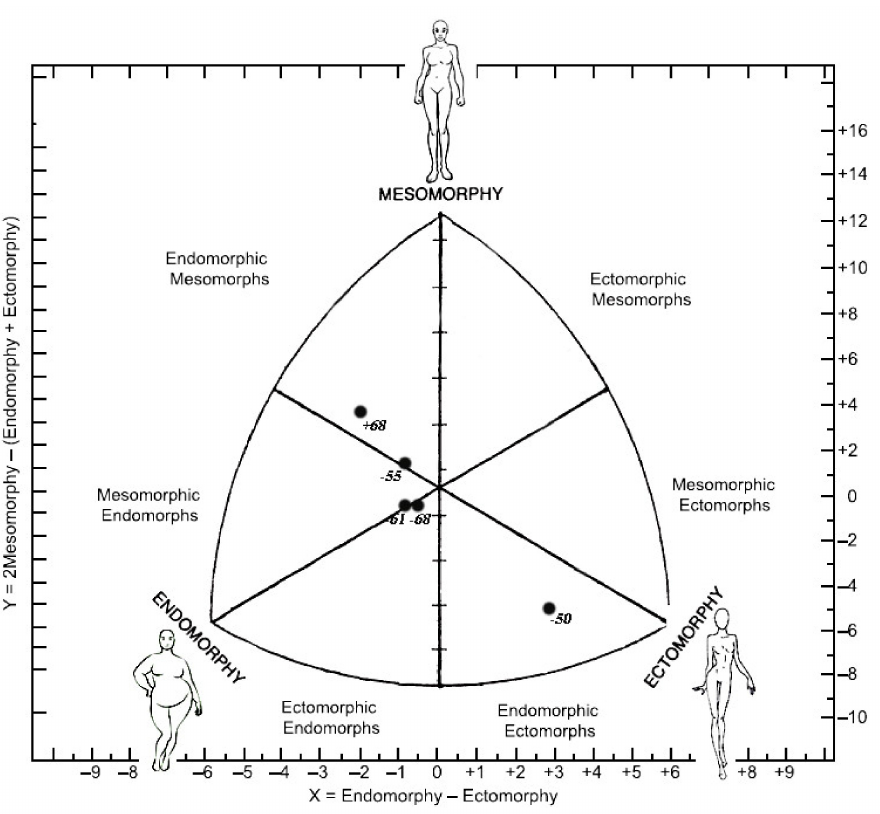
Figure 2. Somatochart of female karate athletes by weight